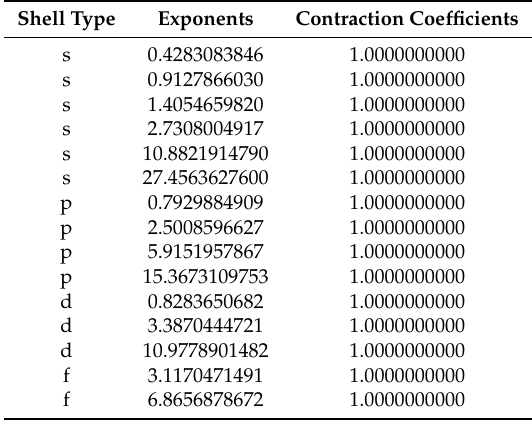
Table A24. Parameters of the cc-DZVP auxiliary basis set of Neon.